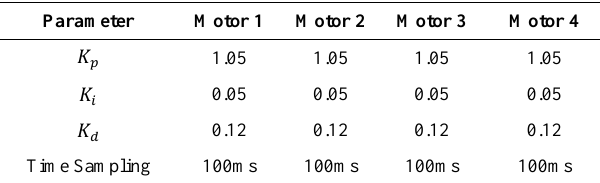
Table 3. Motor Speed PID Tuning Results